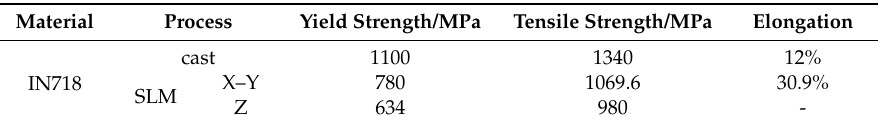
Table 4. Results of tensile tests.